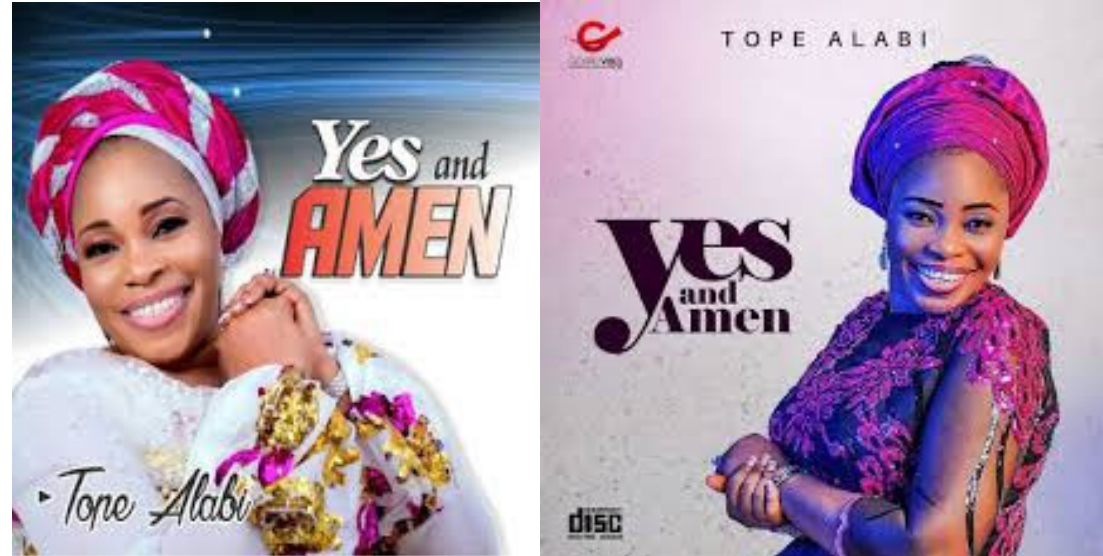
Figure 1. Tope Alabi on the covers of her 2018 album, Yes and Amen. (Images: courtesy of Gospel Vibes Music Records, Oshodi, Lagos. accessed on 10 December 2021).